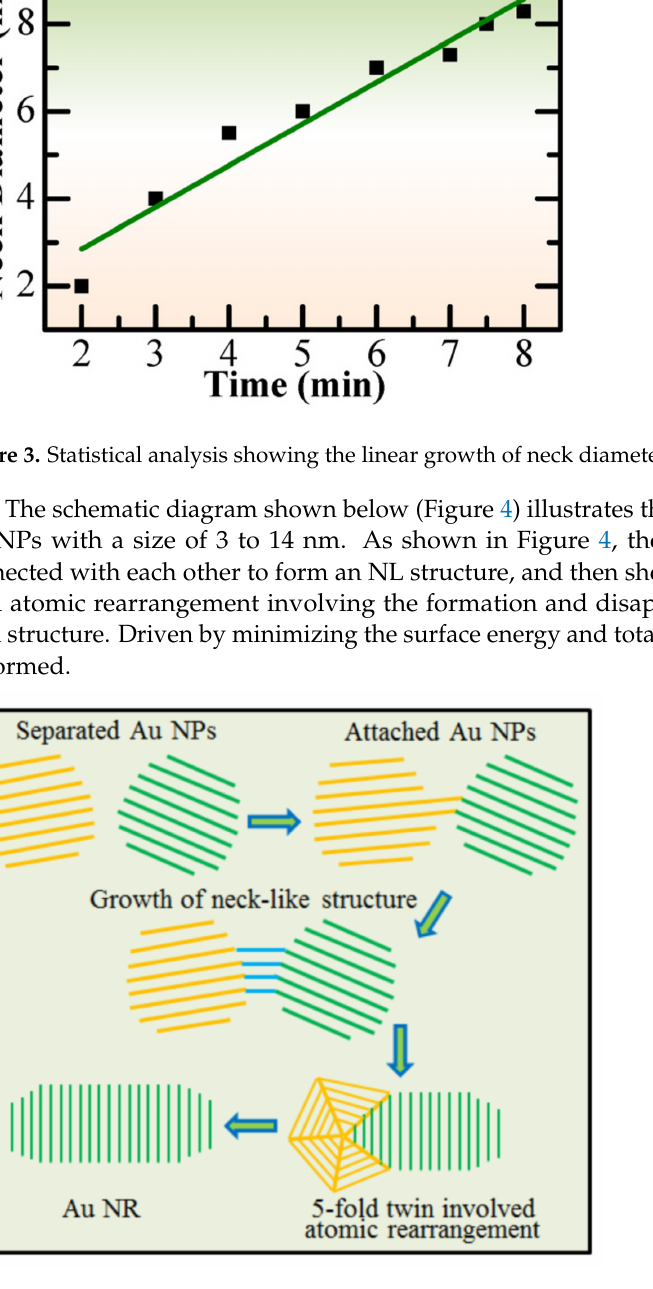
Figure 4. Schematic diagram showing the formation of Au NR by the attachment of Au NPs with a size of ~10